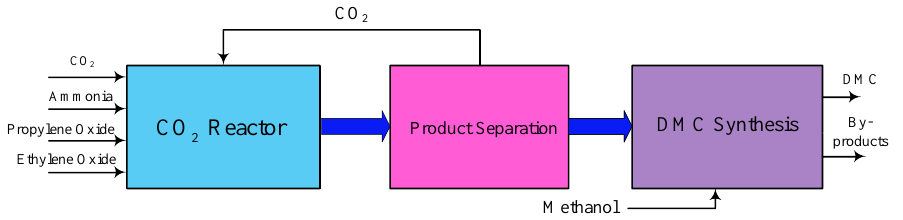
Figure 2. Concept of DMC production from carbon dioxide